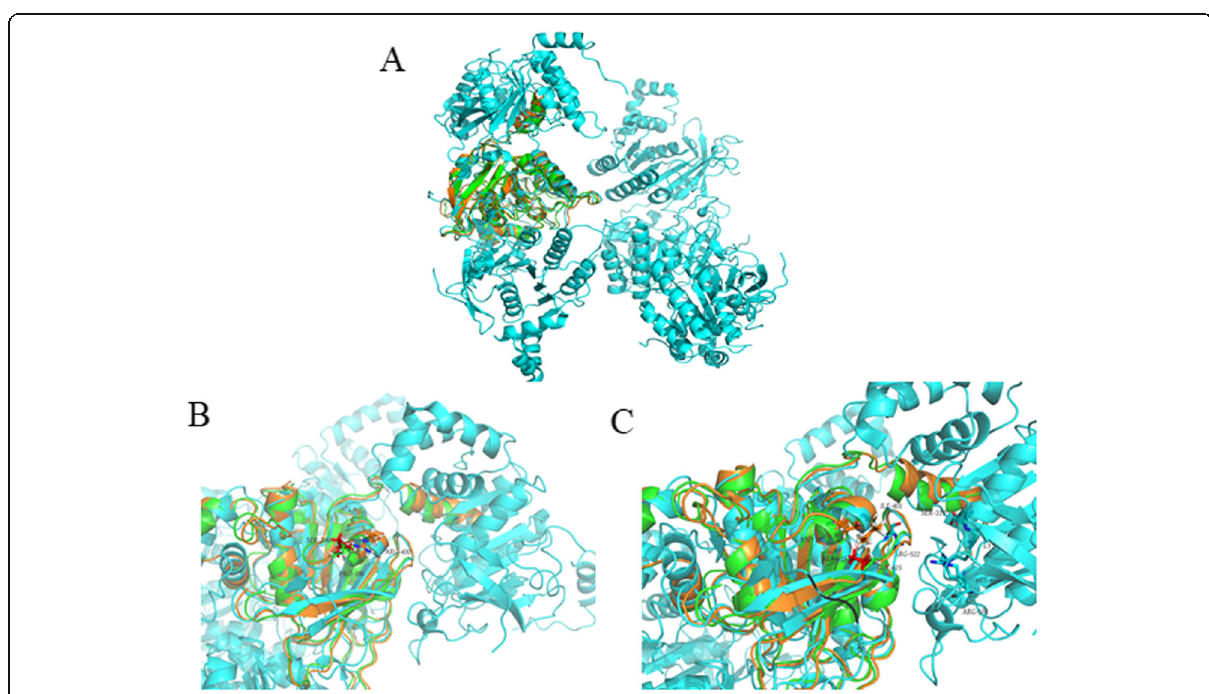
Fig. 4 Model of the three-dimensional structure of Twinkle protein (The homohexameric T7 gp4 helicase domains are in cyan). ( a ) The modeled protein green and superimposed with the blue subunit. Mutated protein is in orange. ( b ) Magnification of the the linker domain where Pro396 is localized at. Mutated Ser396 is in red. ( c ) Magnification of the the linker domain where Gly615 is localized at. Mutated Ala 615 is in